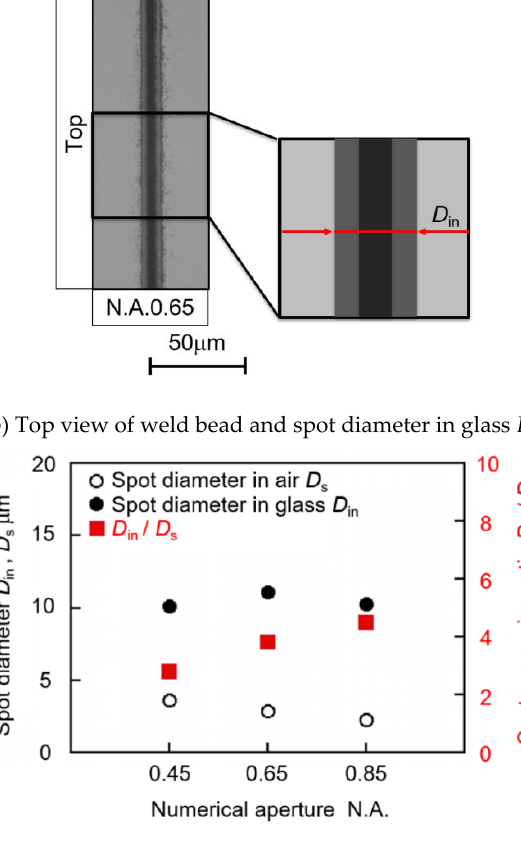
Figure 9. Measurement method and results of diameter of laser spot focused in glass.